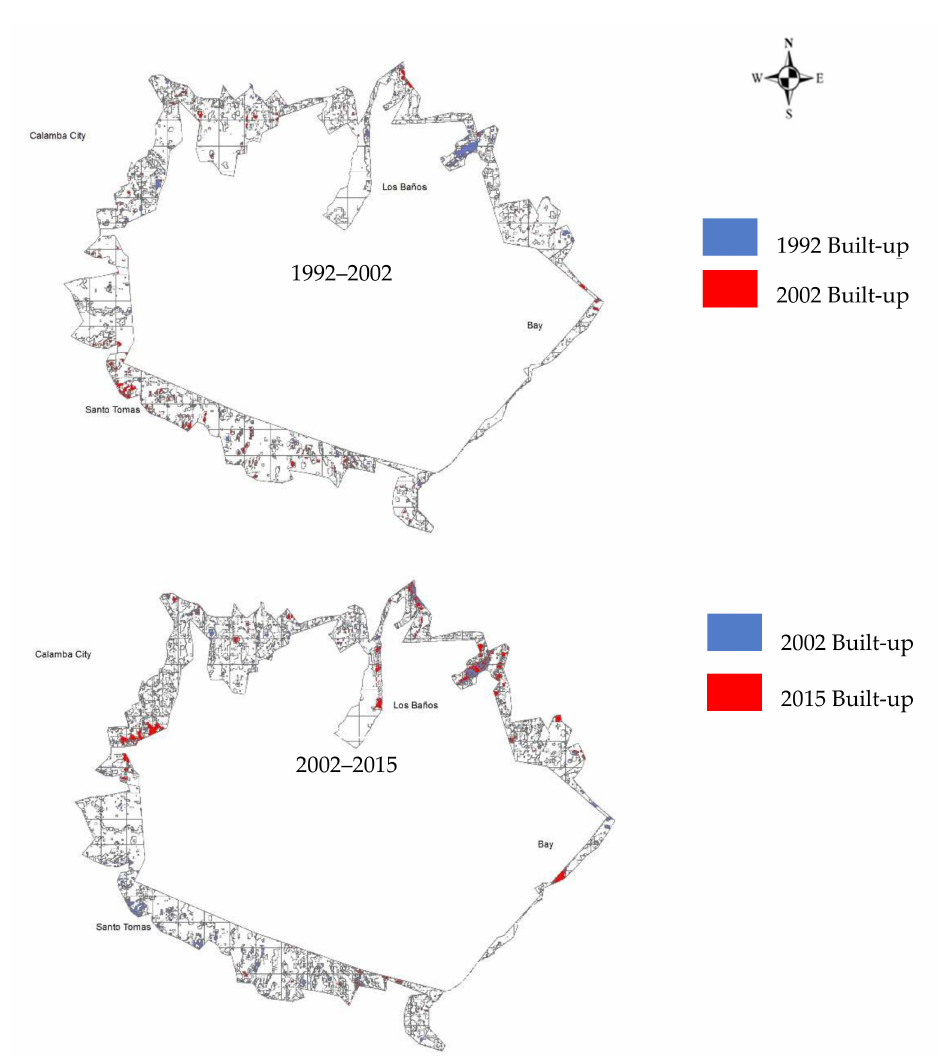
Figure 9. Urban Sprawl in MMFR Buffer Zone from 1992–2002 and